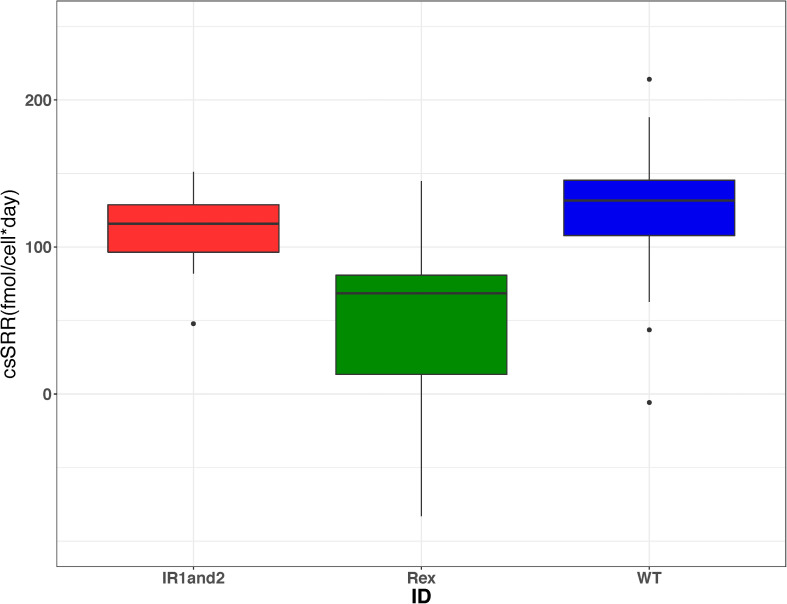
Boxplots showing the range of cell-specific sulfate reduction rates (csSRR) calculated from each harvested bottle in each of the three strains from the Rex batch culture experiments. These results show that the csSRR for the wild type is greater than that in the Δrex strain, but indistinguishable from the IR1and2 strain. The data for WT, IR1and2, Δrex are in dark blue, red, and green, respectively.